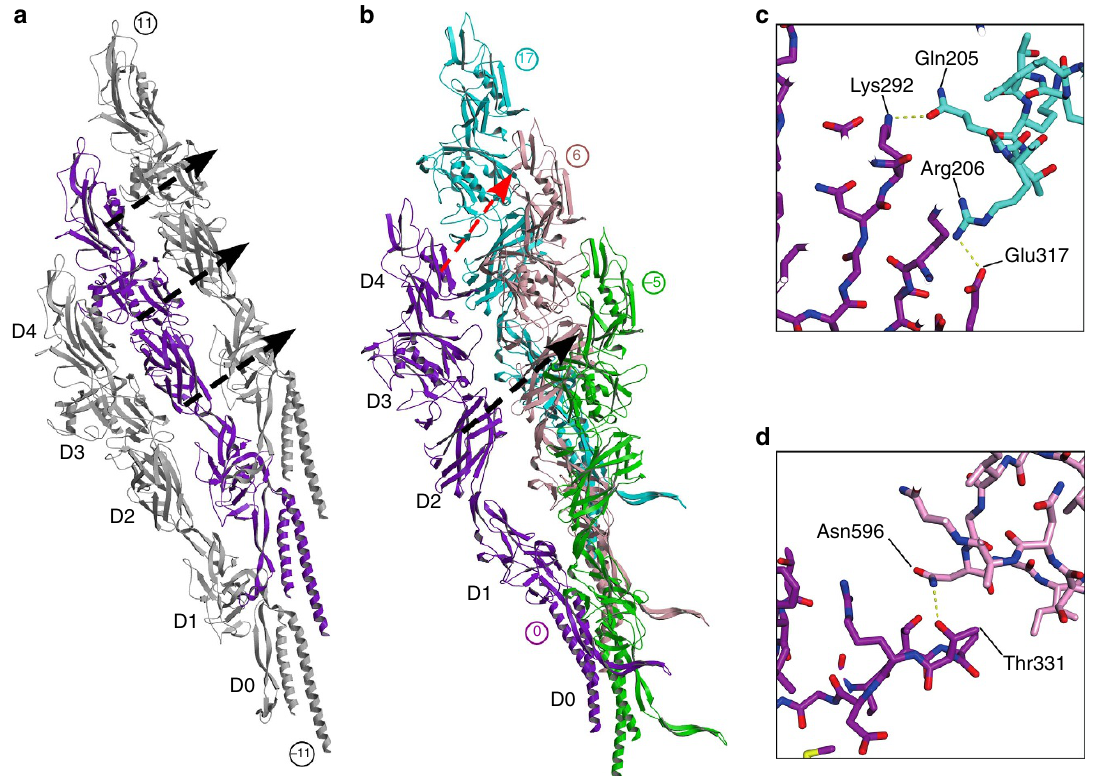
Figure 6 | Interactions within and between protofilaments. Two protofilaments taken on each side of the hook and showing the interactions in the 11-start direction between domains D2–D1, D3–D2 and D4–D3 ( a ). Four molecules of FlgE taken from two neighbouring protofilaments with the interactions in the 6-start (black dashed arrow) and in the 17-start (red dashed arrow) ( b ). The numbers indicate the order of appearance of each FlgE molecule during the building of the hook. Figure prepared with MOLSCRIPT 44 and RASTER3D (ref. 45). Closed-up views of side-chain interactions in the 17-start direction between domain D4–D3 ( c ) and the 6-start interaction between D2–D2 ( d ). Figures are prepared using the same colours used in b with